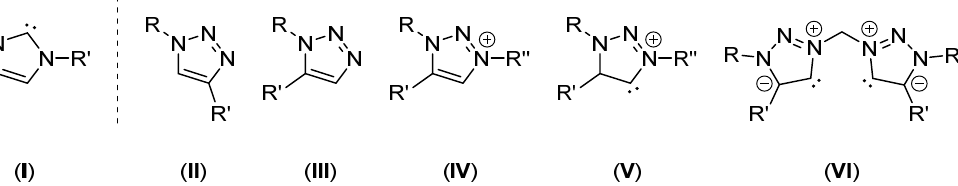
Figure 1 . Triazole derived precursors and N-heterocyclic carbene (NHC). The well-known imidazole-2-ylidene ( I ) is shown for comparison reasons. 1,4-triazole ( II ) is obtained with a CuAAC; 1,5-triazole ( III ) is obtained in a base or Ru-catalyzed combination of azide (R) and alkyne (R ′ ). N-alkylation (R ″ ) of the 1,5-triazole yields the triazolium salt ( IV ) which is transformed by deprotonation to 1,2,3-triazol-4-ylidene ( V ). Using a bridging alkylation agent, a bis-1,2,3-triazol-4-ylidene ( VI ) can be obtained [8,11,12] .